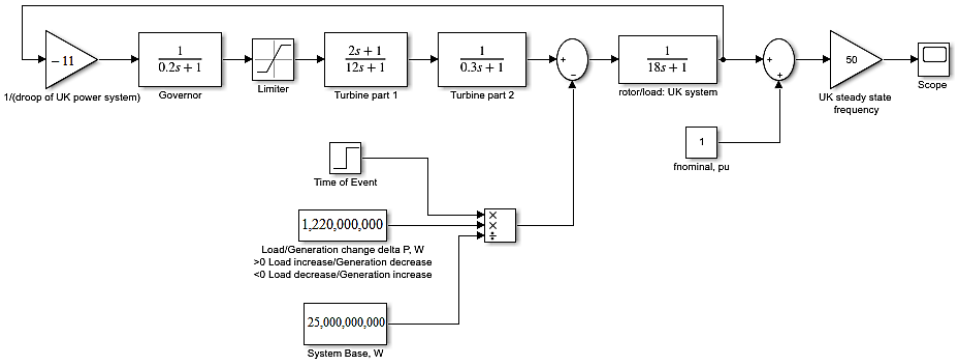
Figure 7. Simplified equivalent-generator system SIMULINK